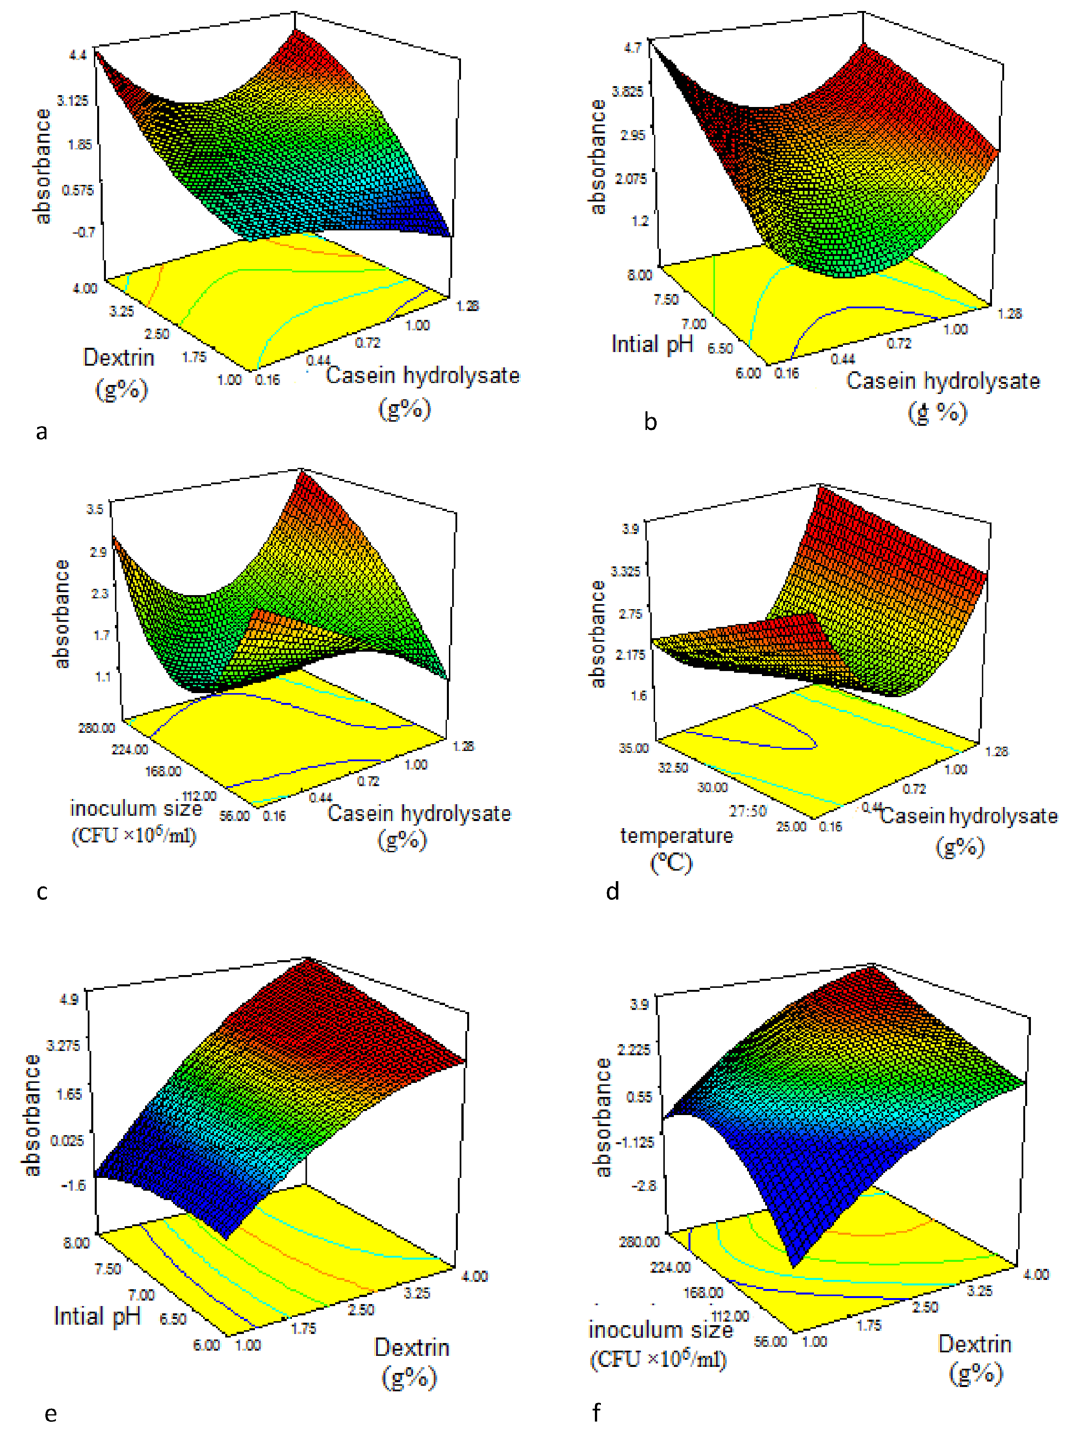
Figure 2. 3D response surface plot for the effect of different factors on AuNPs biosynthesis and factor-factor interactions between ( a ) casein hydrolysate and dextrin ( b ) casein hydrolysate and initial pH ( c ) casein hydrolysate and inoculum size ( d ) casein hydrolysate and temperature ( e ) dextrin and initial pH ( f ) dextrin and inoculum size ( g ) dextrin and temperature ( h ) initial pH and inoculum size ( i ) initial pH and temperature ( j ) inoculum size and